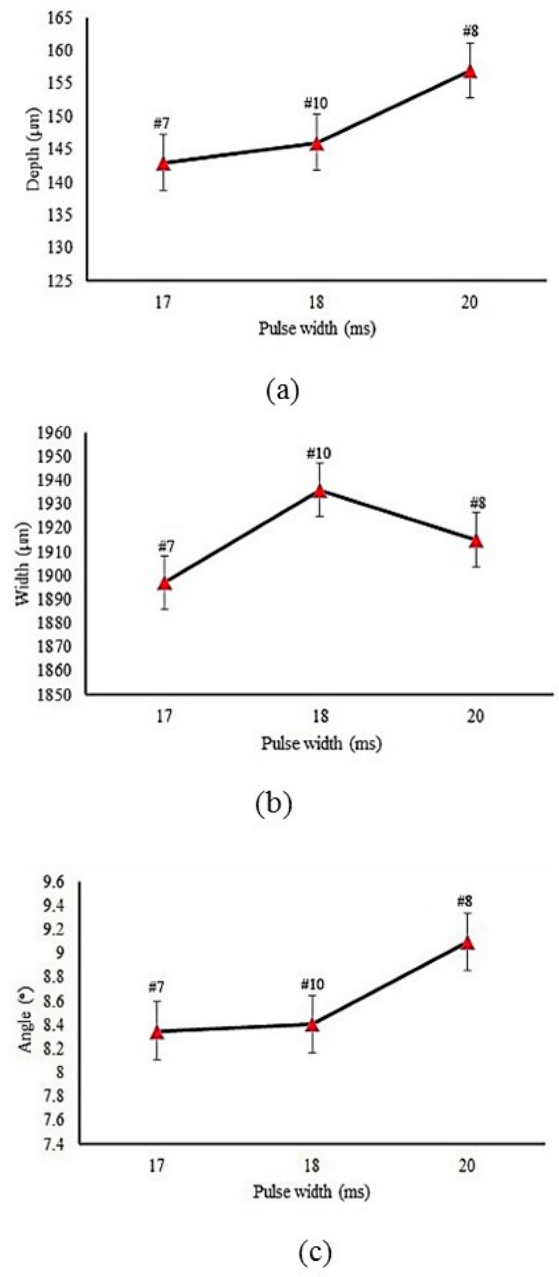
Figure 8. Influence of the pulse width on LH profile geometry. ( a ) Pulse width on depth (samples #7, #8, and #10); ( b ) pulse width on width (samples #7, #8, and #10); ( c ) pulse width on angle (samples #7, #8, and #10).